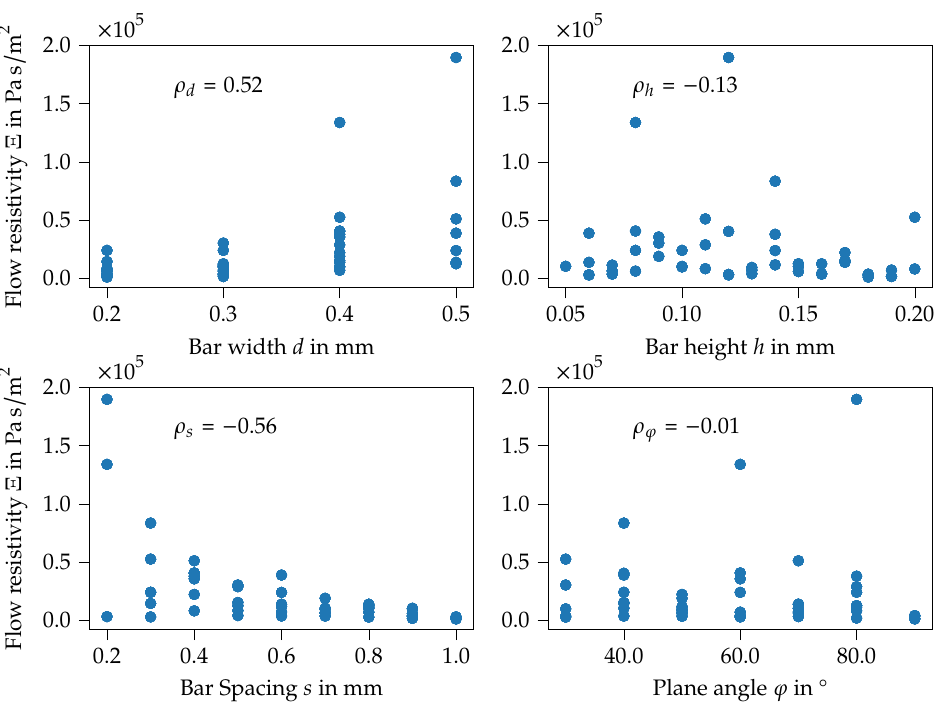
Figure 9. Correlation of the flow resistivity and the design variables of all manufactured specimens. It can be seen that only the bar width and the bar spacing show a relevant correlation with the flow resistivity, whereas the flow resistivity does not (linearly) depend on the bar height and plane